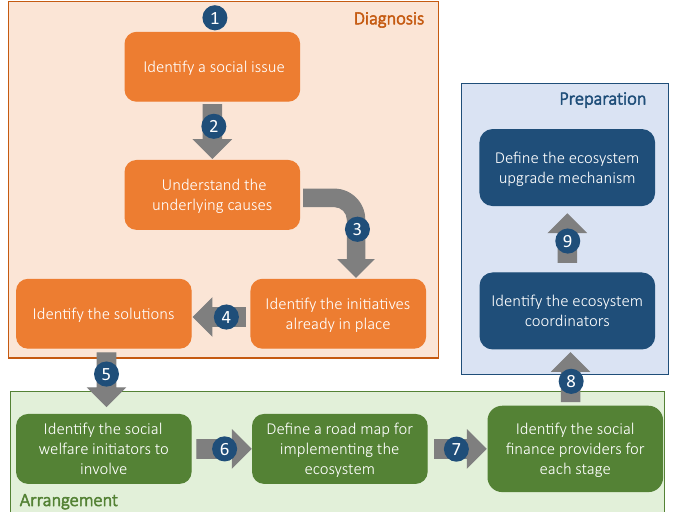
Figure 9. The steps to build